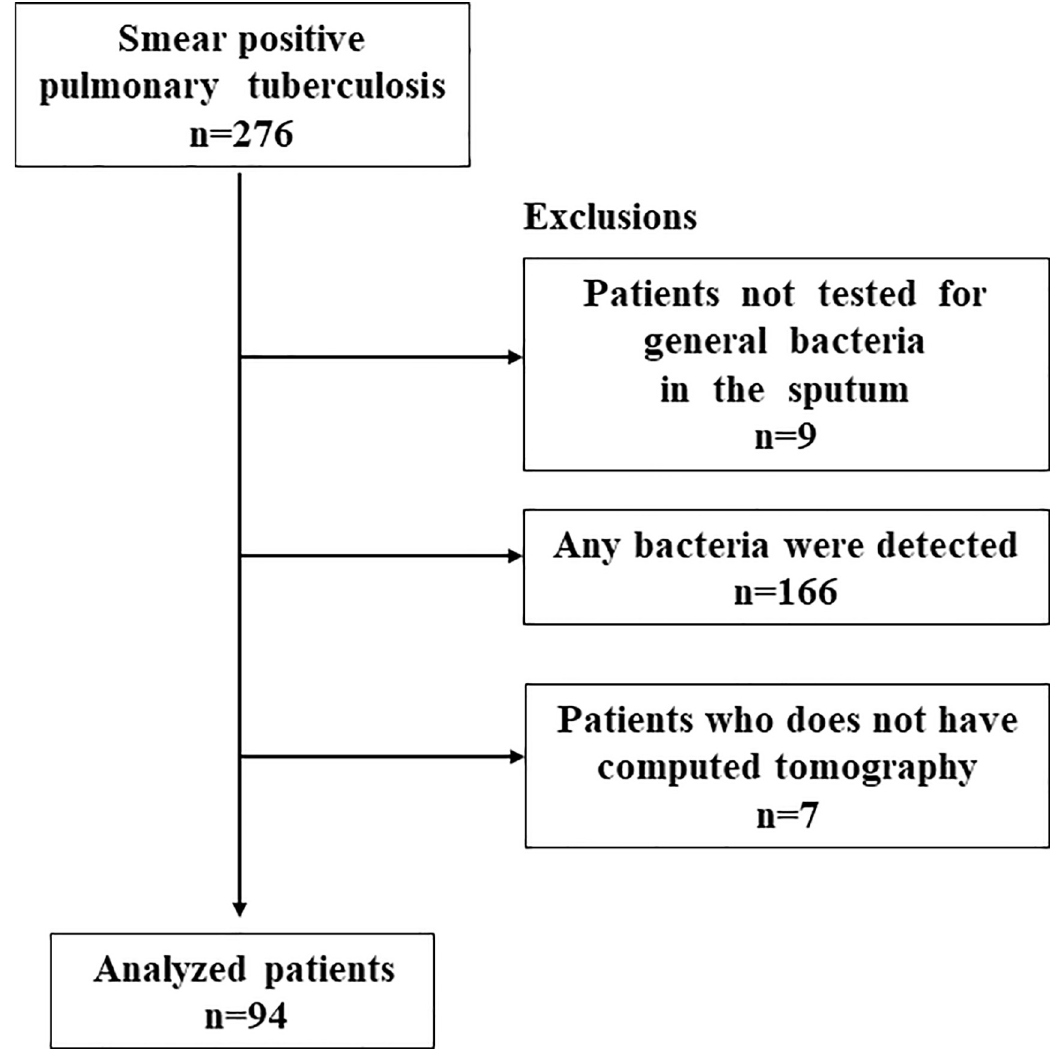
Fig 1. Flowchart of participant